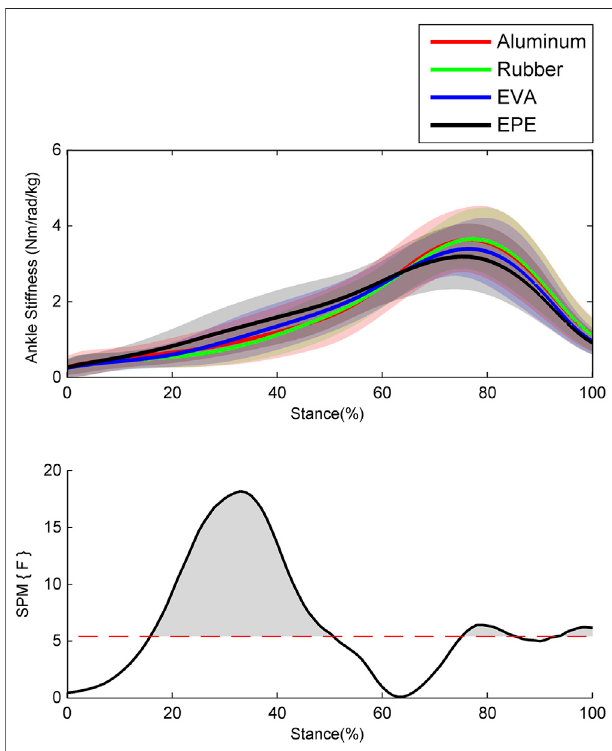
FIGURE 3 | Ensemble average curves (continuous line) and standard deviation(shadedarea)foranklestiffnessduringwalking.Dataarereportedfor the stance phase ofwalking with 0%being heelstrike and 100% being toe-off events. The shaded areas in the SPM fi gure indicate that signi fi cant difference was found ( p < 0.05) during this